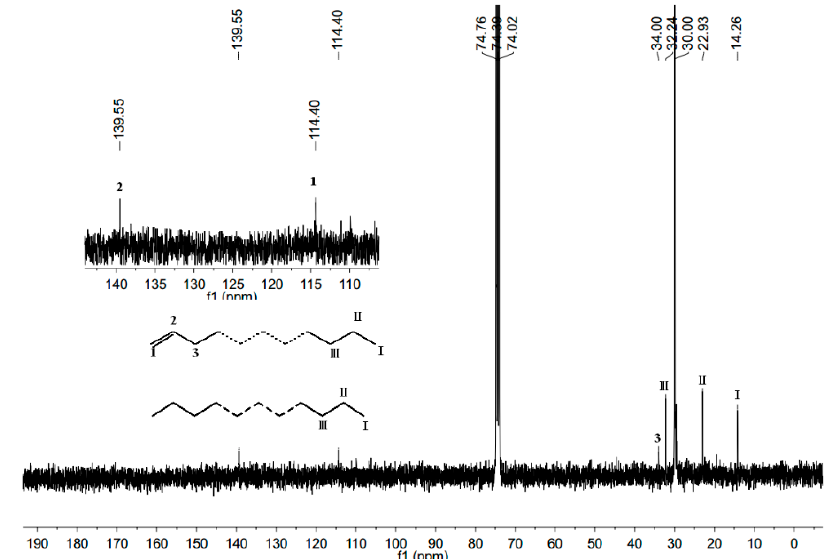
Figure 8. 13 C ‐ NMR spectrum of the polyethylene obtained using Co2 /MMAO at 50 °C (run 3, Table 3); recorded in 1,1,2,2 ‐ tetrachloroethane ‐ d 2 at 120 °C.